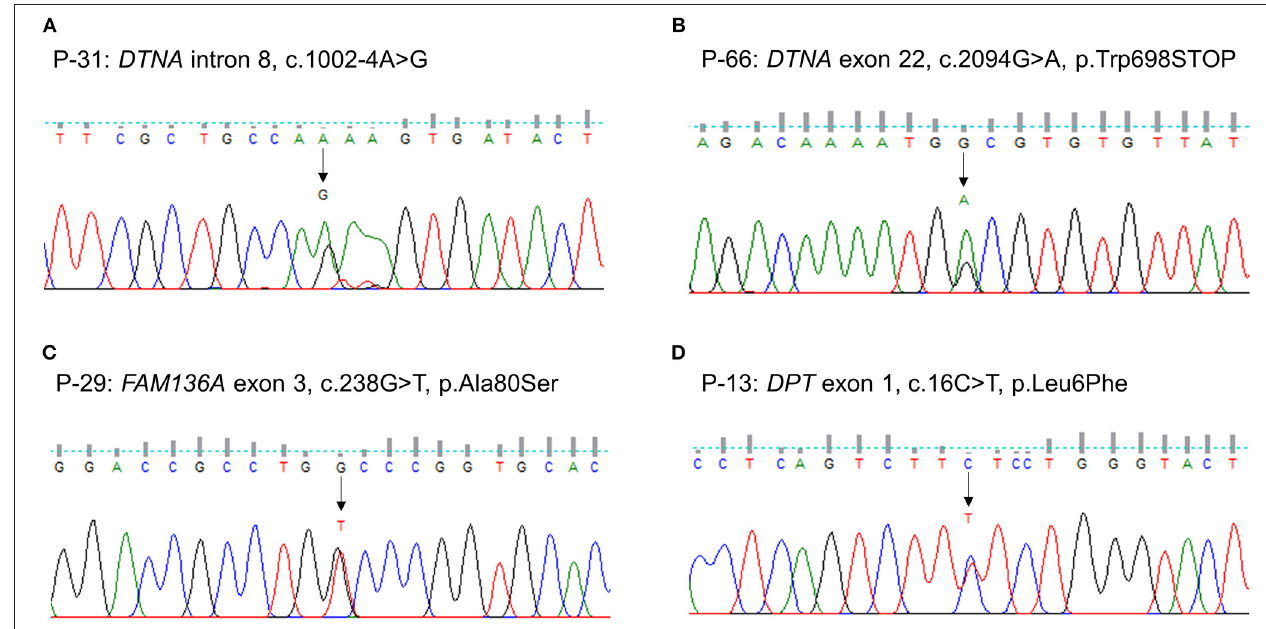
FIGURE 1 | Sequencing results of the rare variants in familial MD genes identified by targeted next-generation sequencing. The chromatograms show two rare heterozygous variants in DTNA : (A) one is a splice site variant at the 4th nucleotide of the splice acceptor site in intron 8 (c.1002-4A > G, P-31); (B) another is a novel nonsense variant in exon 22 causing a premature stop codon (c.2094G > A, p.W698X, P-66). The others are a heterozygous missense rare variant in exon 3 of FAM136A causing the substitution of alanine by serine at position 80 (c.238G > T, p.A80S, P-29) (C) and in exon 1 of DPT changing the highly conserved leucine by phenylalanine at position 6 (c.16C > T, p.L6F, P-13) (D)